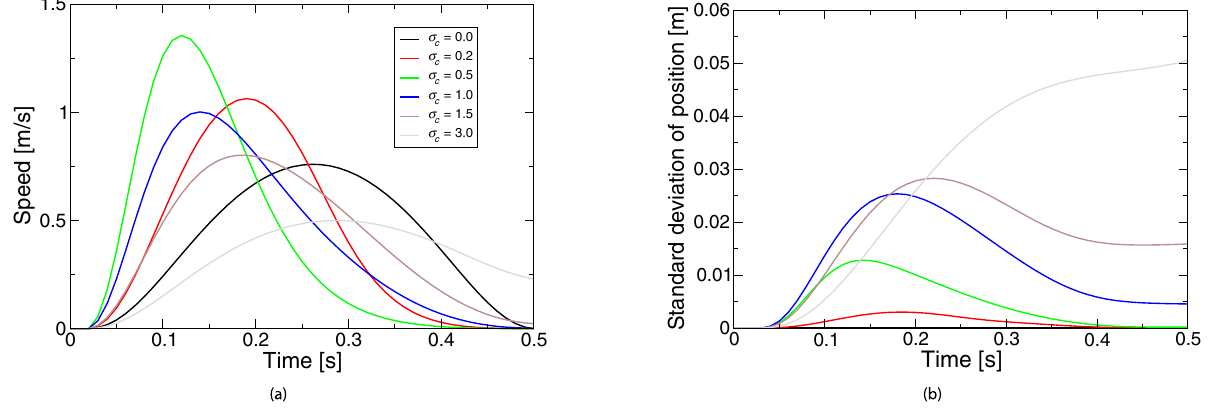
Figure 1. Simulated movements based on the extended LQG for the coefficient σ c of control-dependent noise: ( a ) speed, ( b ) positional variability. The legend of the subfigure ( b ) is the same as the subfigure ( a